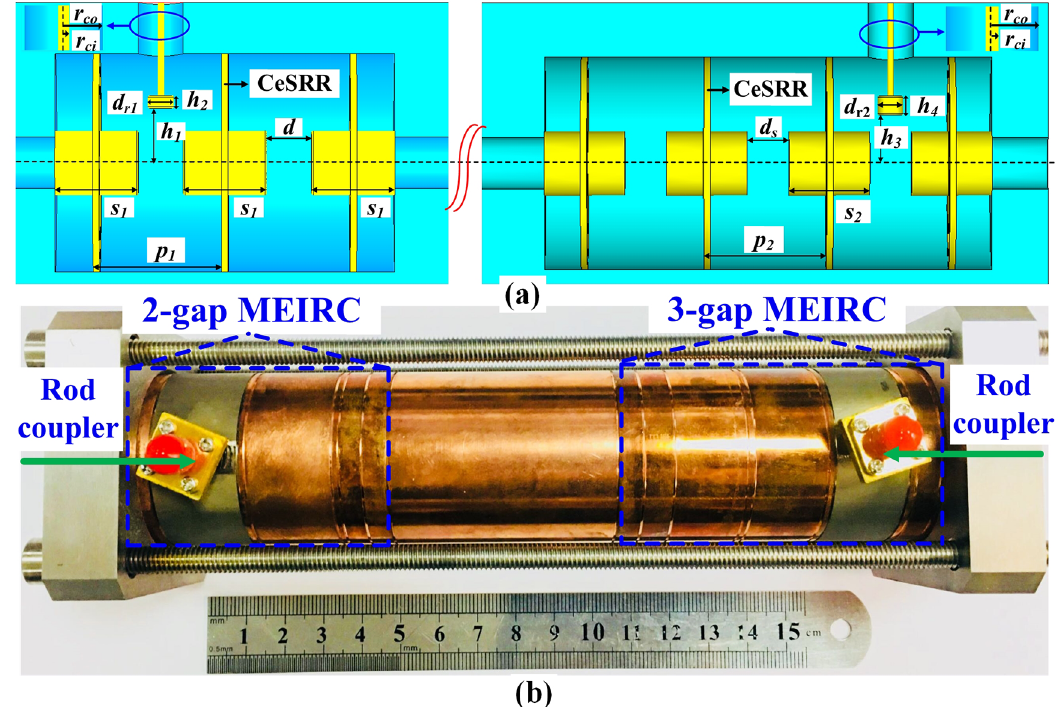
Fig. 8. Simulation model and sample of the MTM EIRCs. (a) 2-gap MTM EIRC (left) and 3-gap MTM EIRC (right) with rod couplers and (b) photo of the assembled MTM EIRCs. The parameters are set as p 1 =20 mm, s 1 = 13mm, d =7 mm, h 1 = 11.5mm, h 2 =2 mm,